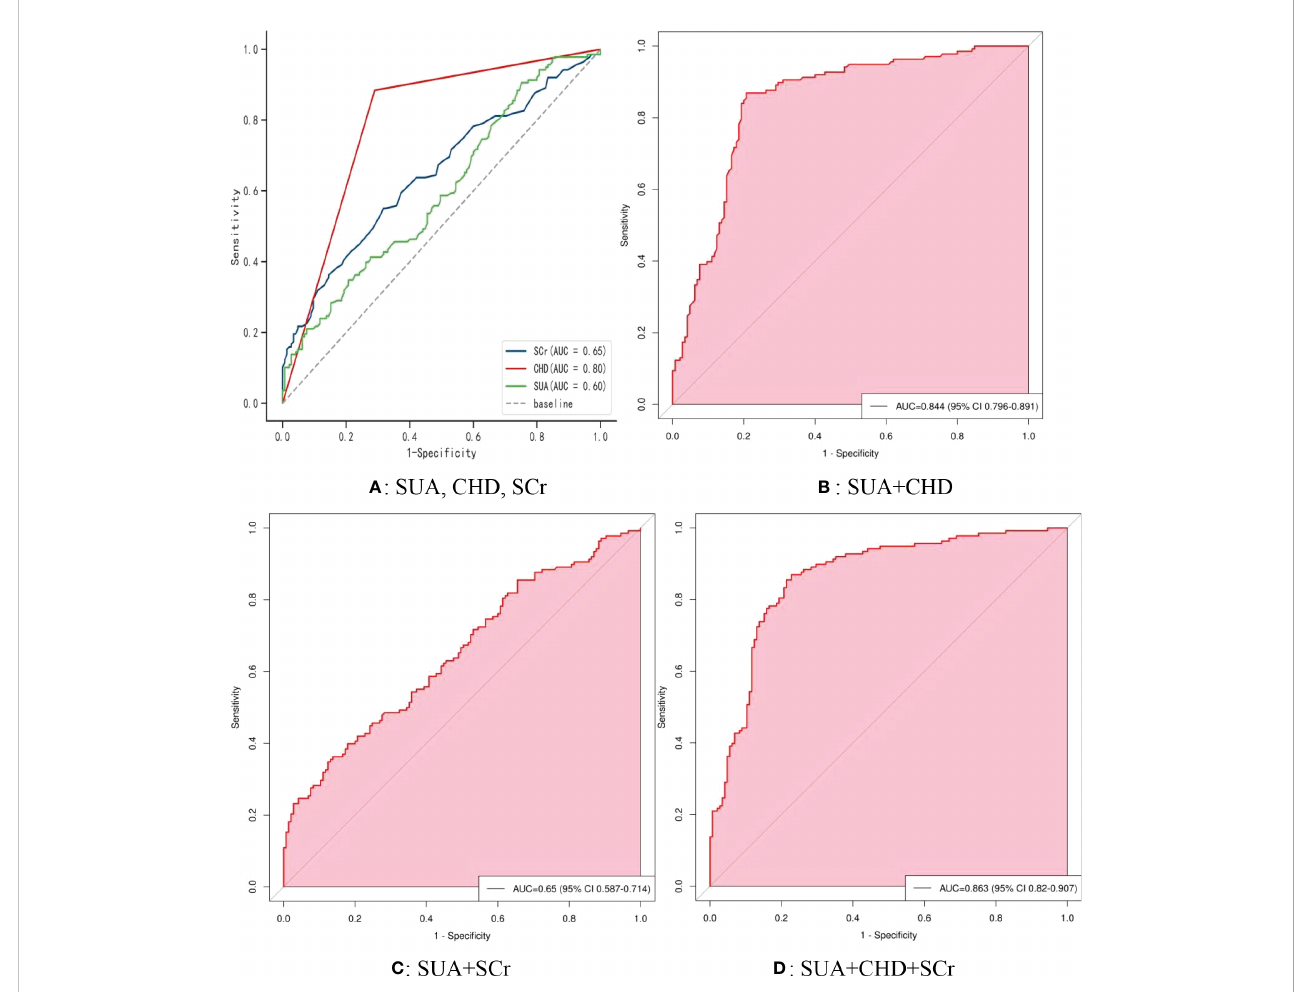
FIGURE 6 The receiver operating characteristic (ROC) curve model of SUA for diagnosing AF in the IFG pattern. (A) Performance of SUA, CHD, and FBG for predicting AF. (B) Performance of SUA combined with CHD for predicting AF. (C) Performance of SUA combined with FBG for predicting AF. (D) Performance of SUA combined with CHD and FBG for predicting AF. IFG, impaired fasting glucose; SUA, serum uric acid; CHD, coronary heart disease; FBG, fasting blood